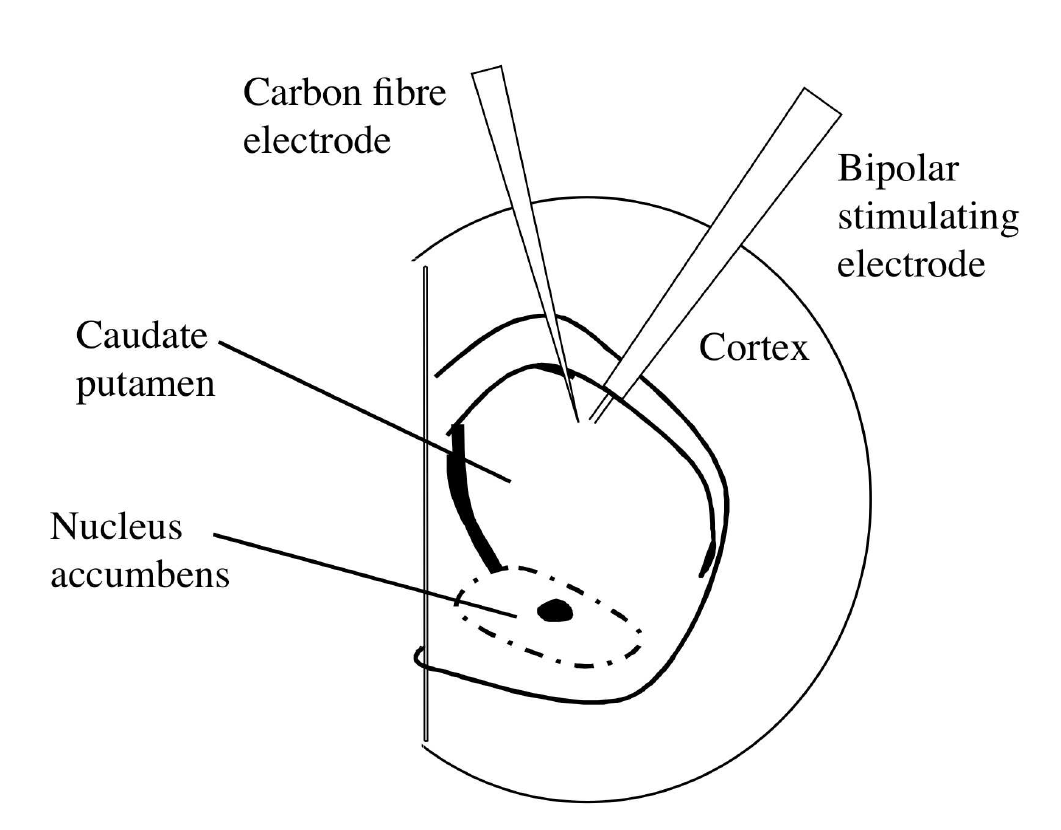
Figure 1. Placement of